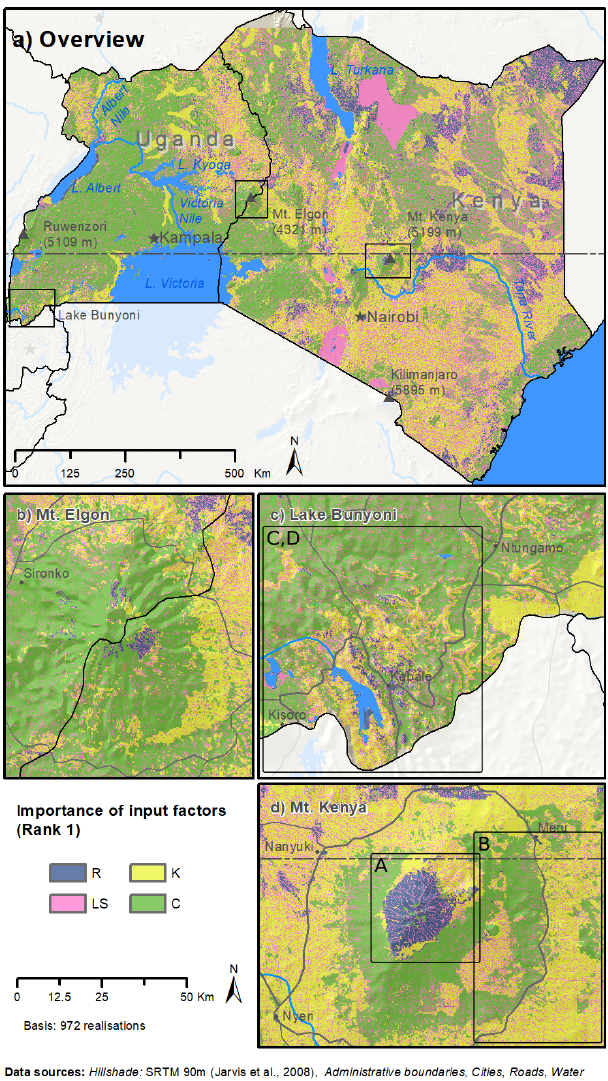
Figure 5. Dominant soil loss levels. The color shows the soil loss level predicted by the majority of USLE model setups. The light- ness of the color indicates the percentage of models that predicted the dominant soil loss level. Panel (a) shows the study area of Kenya and Uganda. Panels (b) , (c) , and (d) show erosion-prone ar- eas around Mt. Elgon, Lake Bunyoni, and Mt. Kenya, respectively.